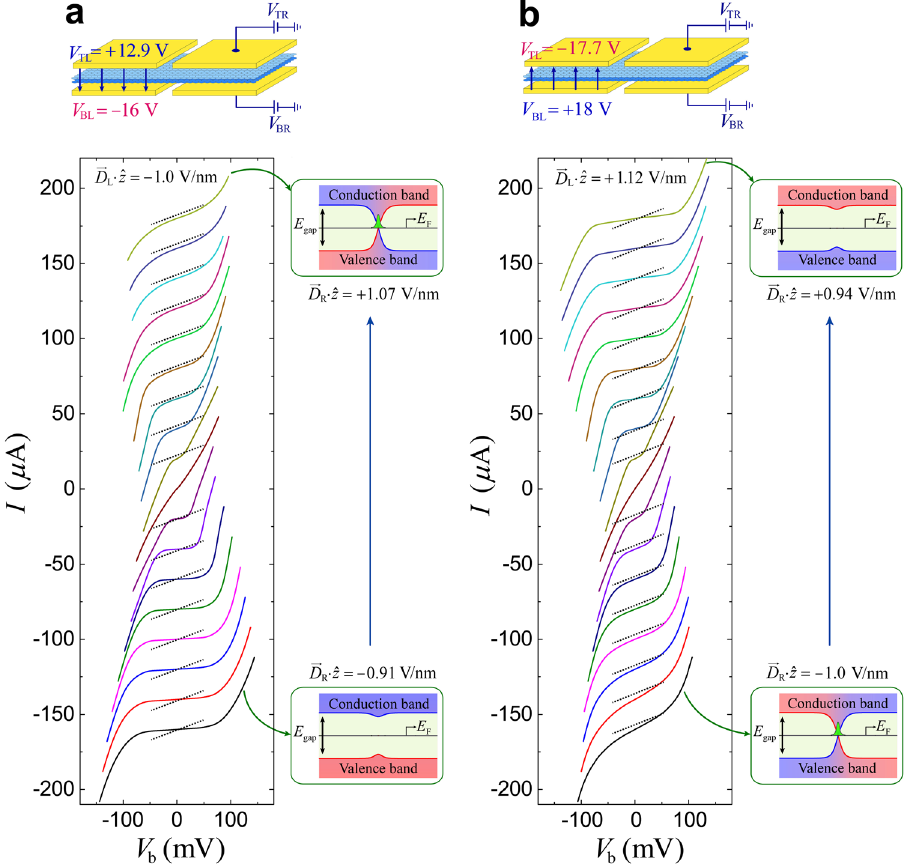
Figure 3. Current–voltage ( I - V ) characteristics in asymmetric-gate configurations. ( a , b ) I – V curves obtained at different points along the diagonal track (from α to β ) in ( a ) Fig. 2b and ( b ) Fig. 2c, respectively. Upper illustrations represent measurement configurations for the two sets of I – V curves. Dotted lines correspond to the slope of 4 e 2 / h